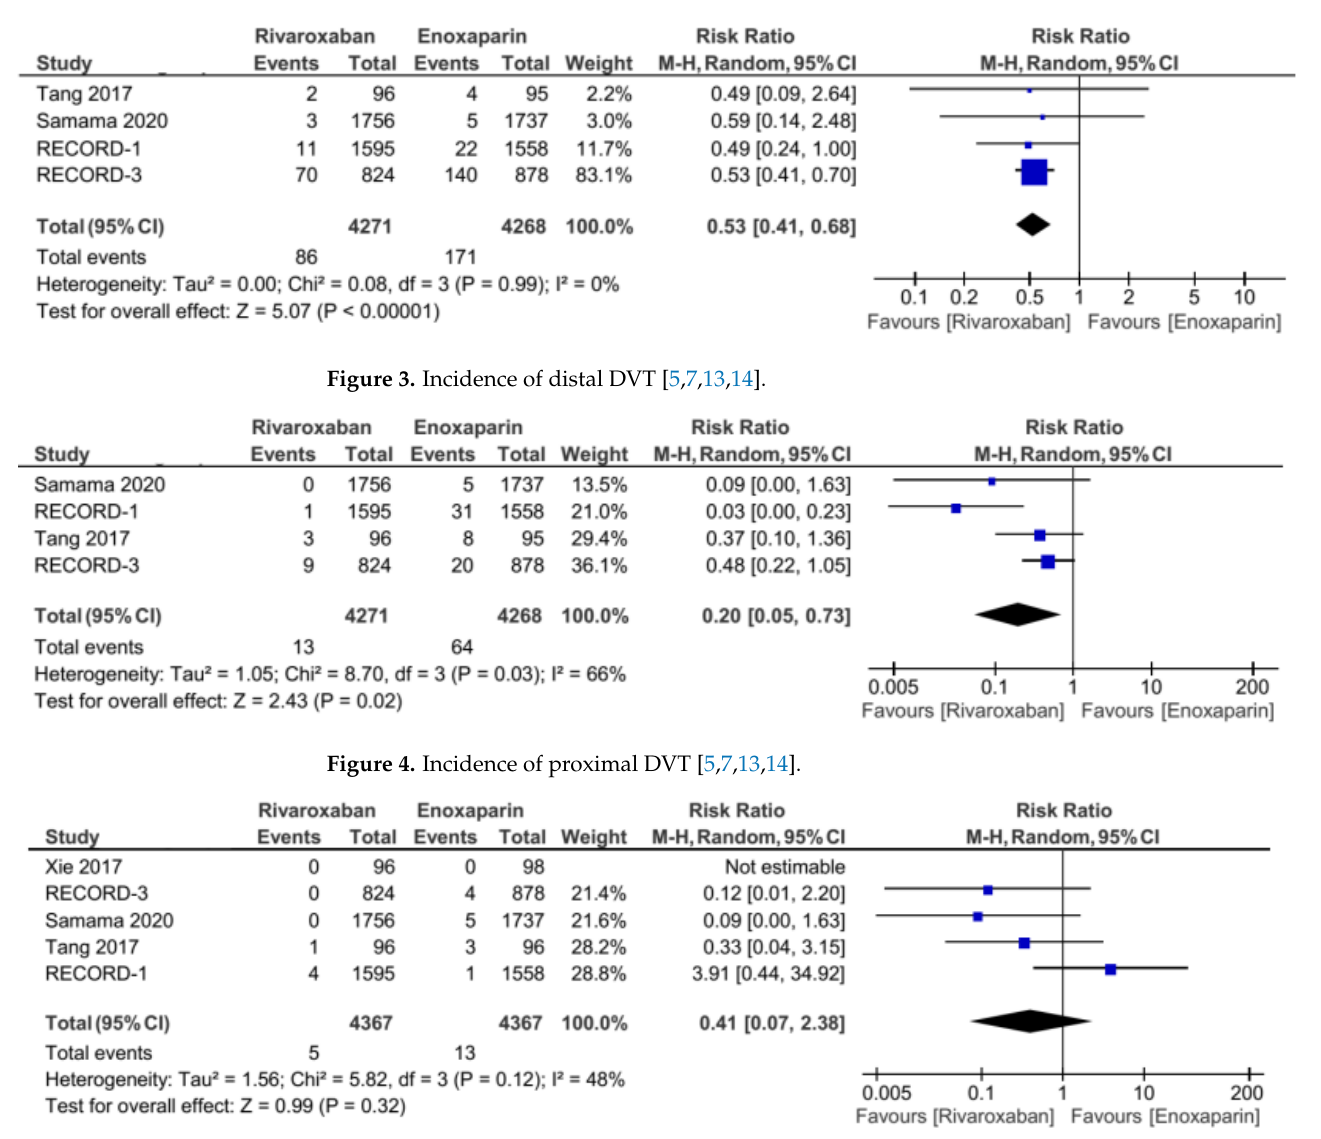
Figure 2. Incidence of any VTE and all-cause death [5,7,12 – 14].